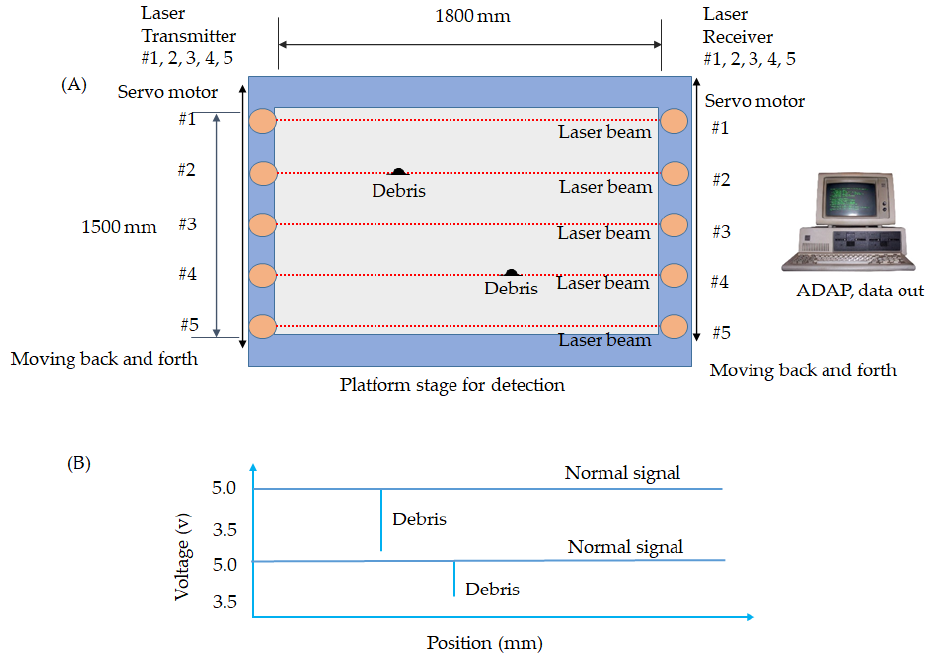
Figure 2. The architecture of the laser sensor illustrating the topology of a thin-film transistor (TFT), ( A ) is a topology of the foreign materials on TFT by laser optics ( B ) is a voltage tendency.